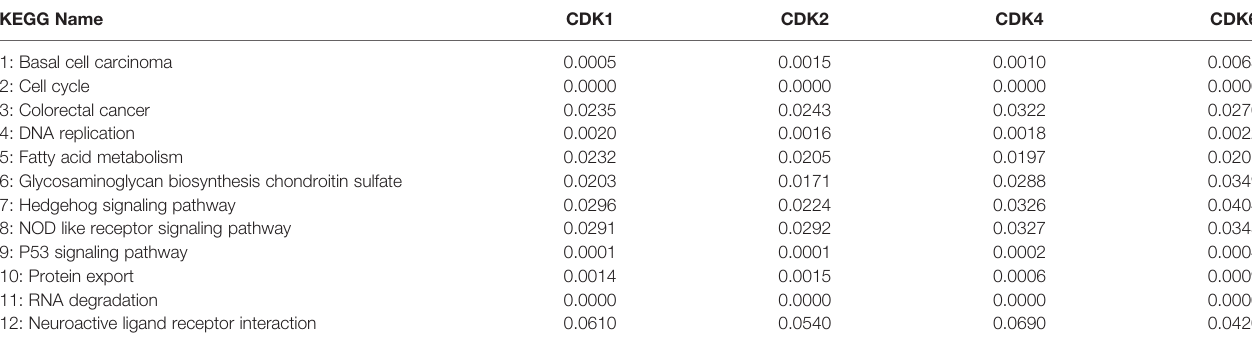
TABLE 1 | The FDR q -values of CDKs in the KEGG pathways based on GSEA.